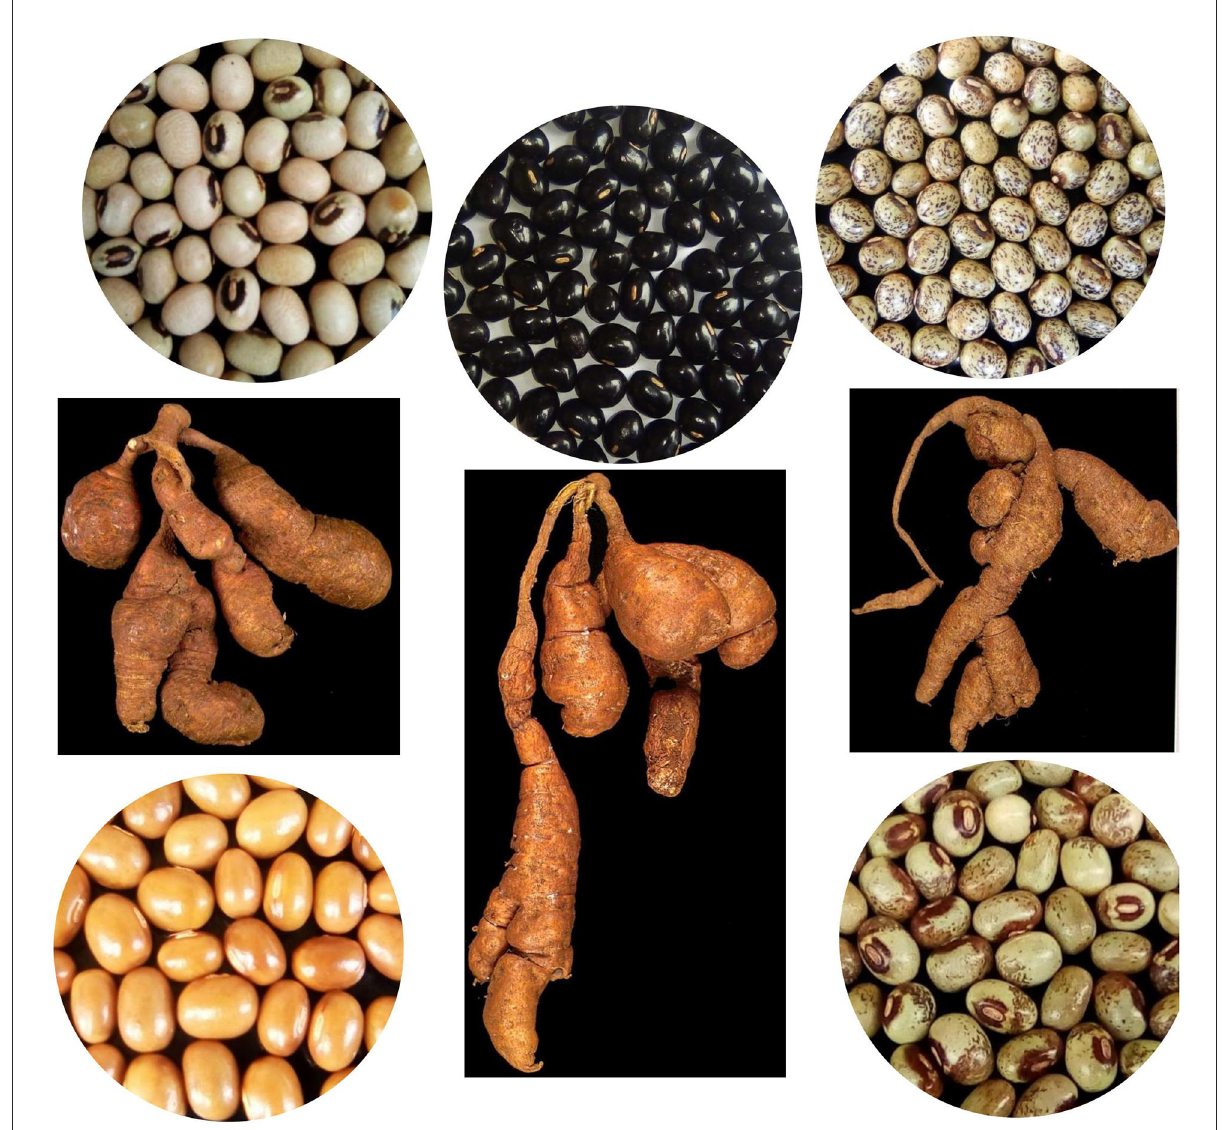
FIGURE1 The two economic products of African yam bean pulses with testa morphs and clusters of tubers with irregular shapes from different accessions. Photo by Adewale